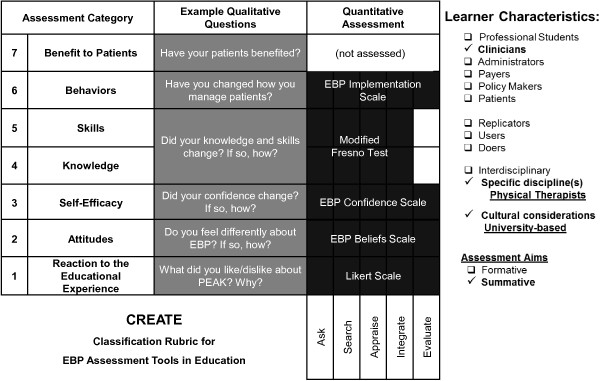
The Classification Rubric for EBP Assessment Tools in Education (CREATE) framework provided the structure for outcome assessment. Left column contains seven CREATE assessment categories; middle column contains simplified examples of the types of questions asked in interviews and focus groups to assess participants’ opinions in each category; right column contains standardized assessment tools used to quantitatively assess change in six of seven categories (shading indicates the EBP steps assessed by each tool). (Modified with permission from Tilson J, Kaplan S, Harris J, Hutchinson A, Ilic D, Niederman R, Potomkova J, Zwolsman S: Sicily statement on classification and development of evidence-based practice learning assessment tools. BMC Med Educ 2011, 11:78).